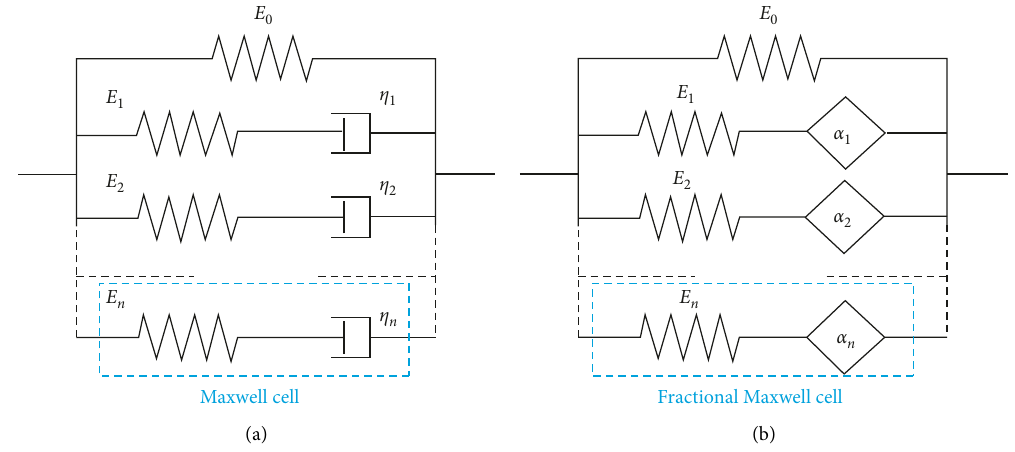
Figure 3: (a) Analytical and (b) fractal Maxwell model for viscoelastic materials